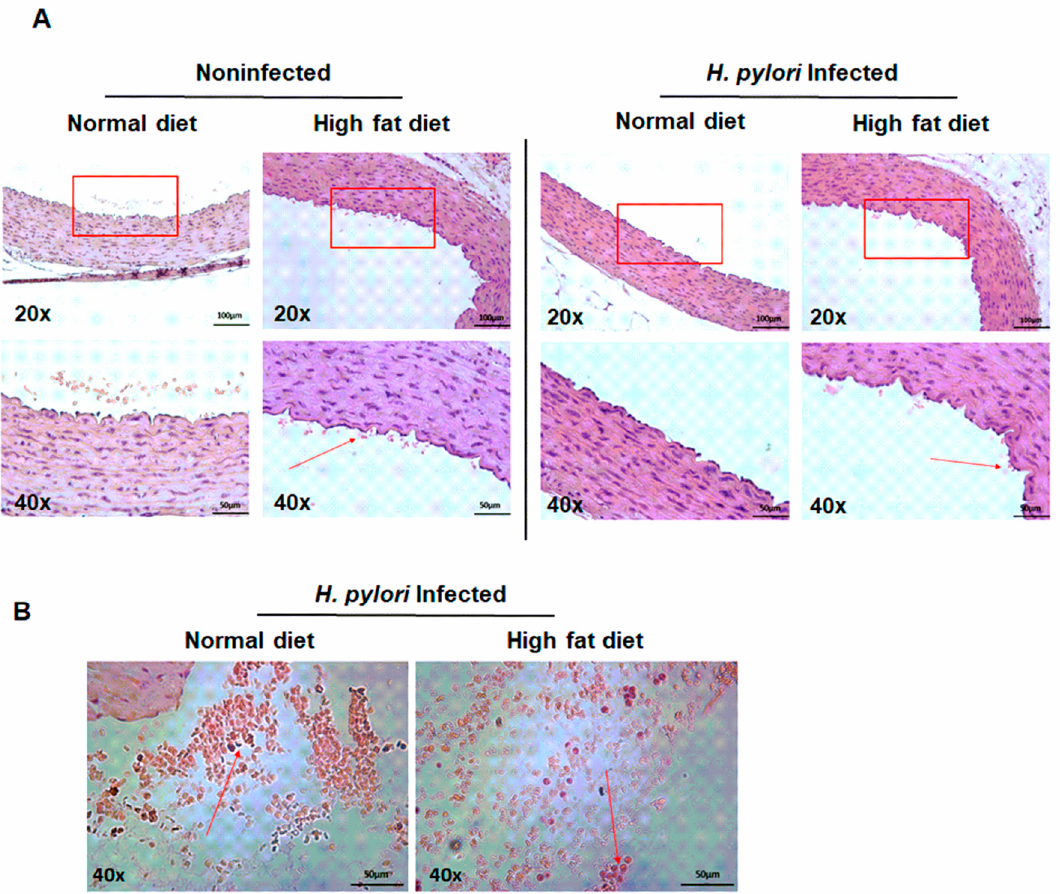
Figure 5. Histological analysis of aortic structure of uninfected and H. pylori -infected animals, at 60 days from inoculation, exposed to normal chow or an experimental high-fat diet. Representative images of H&E-stained thin layers of aortic tissue, visualizing ( A ) the aortic wall layers or ( B ) the aortic lumen. Stained sections were analyzed with light microscopy at magnifications of 200 × and 400 × . The red arrows show the location of the immunocompetent cells and erythrocytes in the nearest proximity to the aortic wall ( A ) or leukocyte cells in the lumen of the aorta ( B ). Five animals per group were examined.